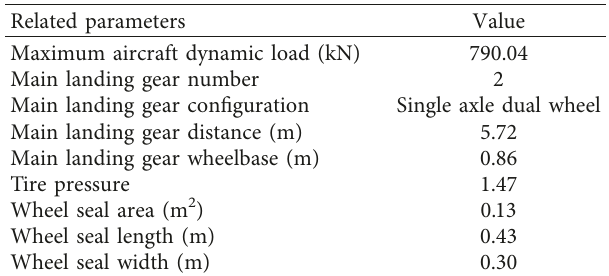
Table 4: Load and structure parameters of the B737-800